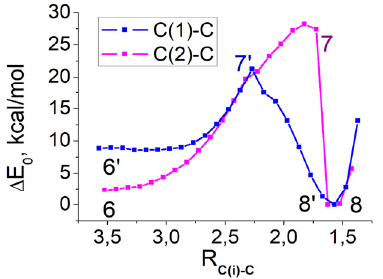
Figure 4. The energy relaxed surface scans of carboxilation via C 1 (blue) and C 2 (purple) carbons, E f = − 53,664.65 eV ( − 1,237,534 kcal/mol).